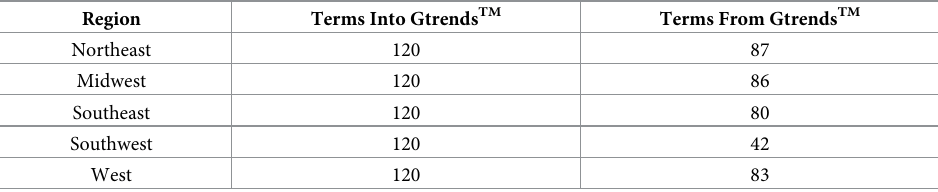
Table 2. Number of search terms that had monthly proportional hit data available from Gtrends TM